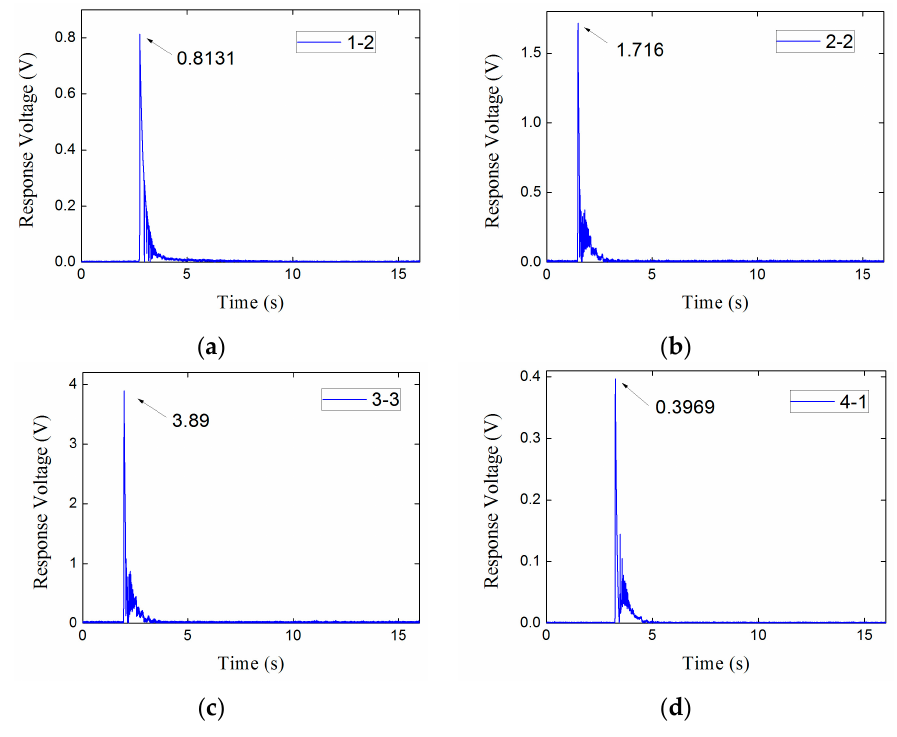
Figure 16. The response voltages. of subsets. ( a ) Subset 1-2; ( b ) Subset 2-2; ( c ) Subset 3-3; ( d ) Subset 4-1.